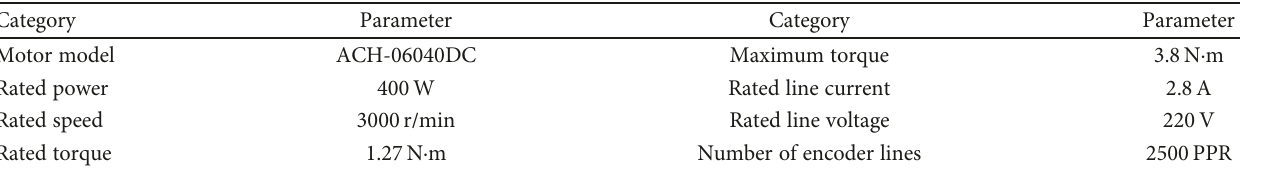
Table 4: Technical parameters of the servomotor.